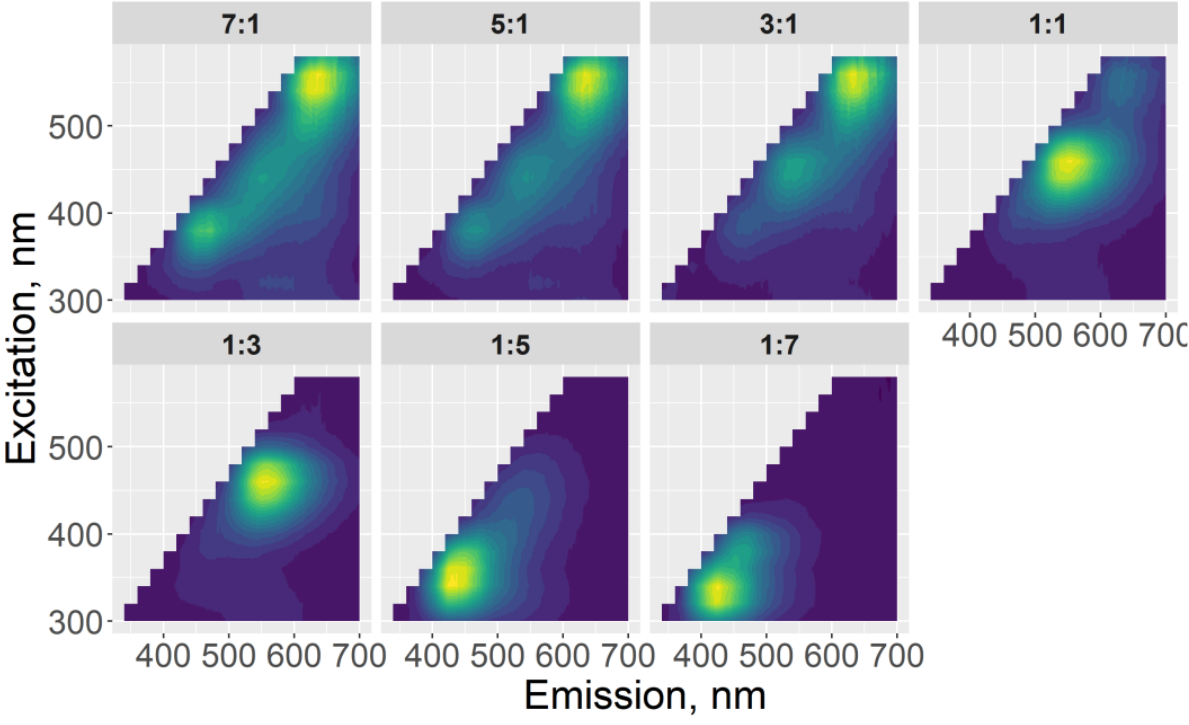
Figure 8. Maps of emission spectra of purified samples prepared from urea and citric acid at different excitation wavelengths. Sample composition (urea/citric acid) is shown in the subplot captions.